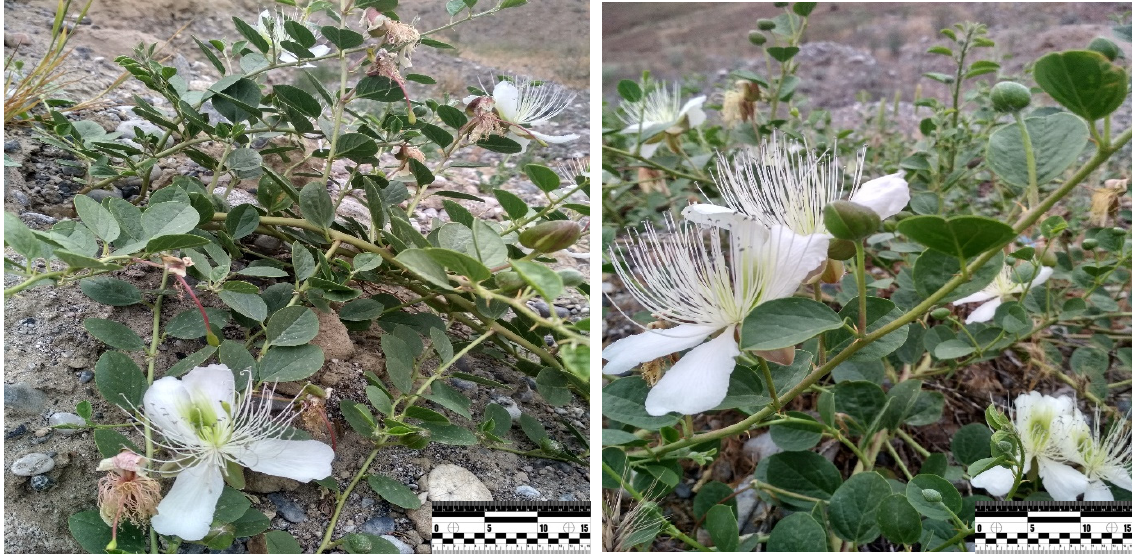
Figure 2. The plant C. spinosa L. growing in the experimental area (Scale: 1:50).